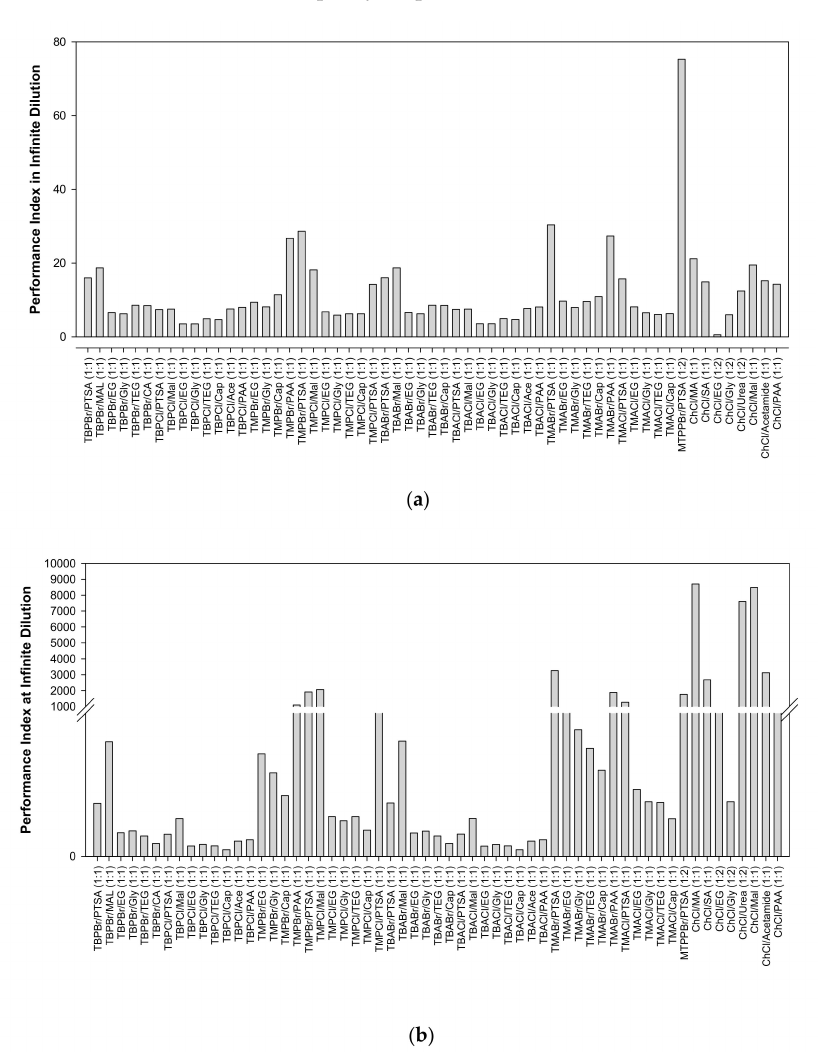
Figure2. ( a )PerformanceindexofDESinheptanesystem,( b )PerformanceindexofDESinpentadecanesystem. Tetramethyl-based DESs have a relatively high-performance index due to their high